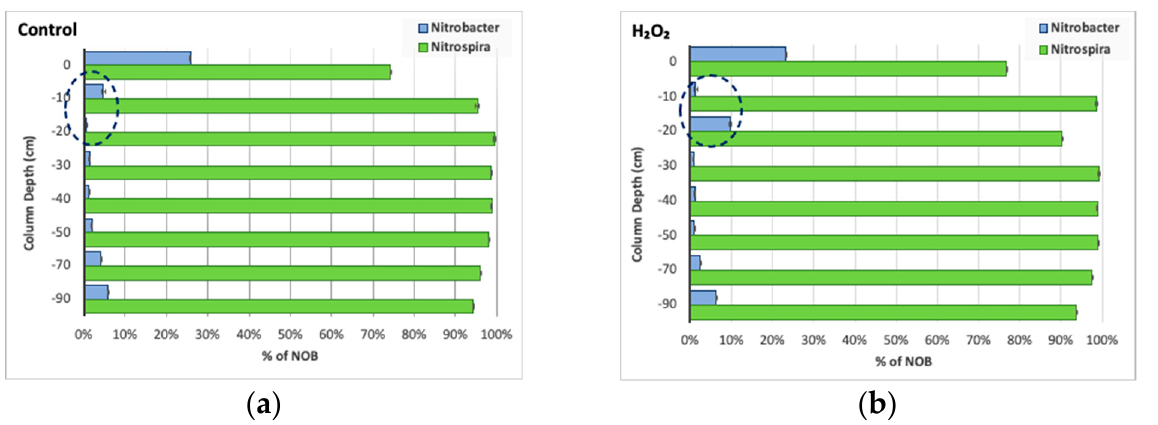
Figure 5. The fraction of Nitrospira spp. and Nitrobacter spp. out of NOB (sum of Nitrospira spp. and Nitrobacter spp.) along column depth, for ( a ) RC and ( b ) HPC. Dotted circle emphasizes the location of significant differences.